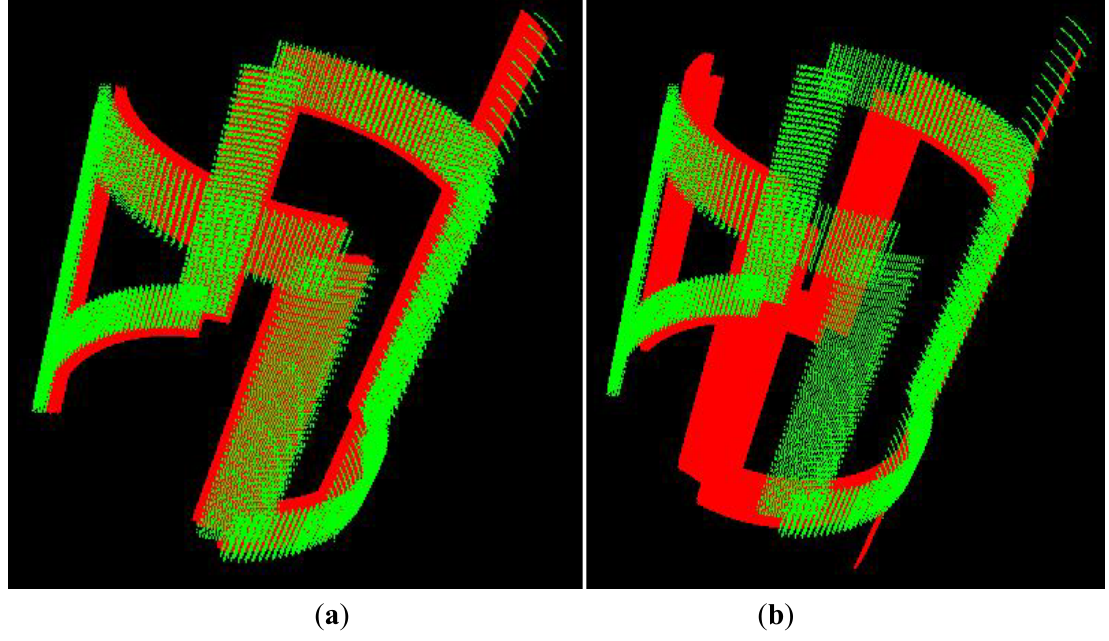
Figure 2. Two different angular positions of the rotor, ( a ) when the vertical conductive segments of the rotor coils are parallel and just above the same segments of the stator coil; ( b ) another angular position of the rotor coil—it corresponds to 30